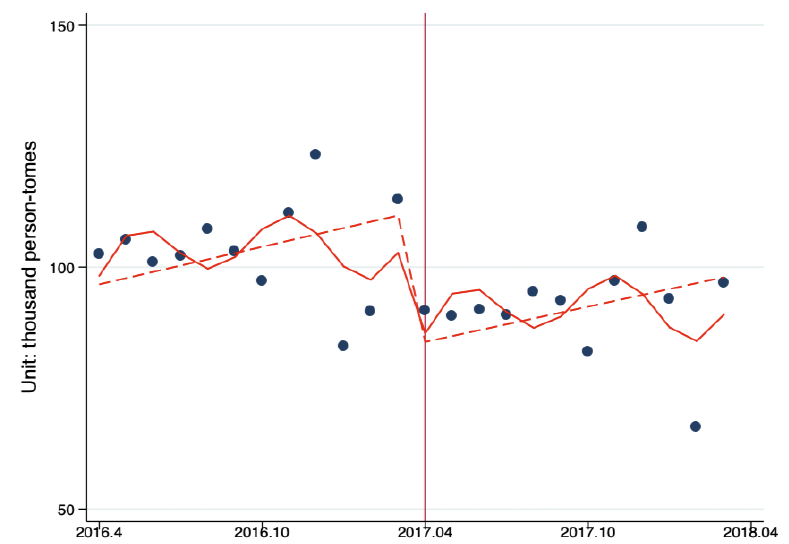
Figure 3. The ITS analysis of monthly outpatient visits per tertiary hospital. Model adjusted for seasonality and autocorrelation. Solid line: predicted trend based on the seasonally adjusted regression model. Dashed line: de-seasonalized trend. Vertical line: intervention began. Blue dots: actual number.